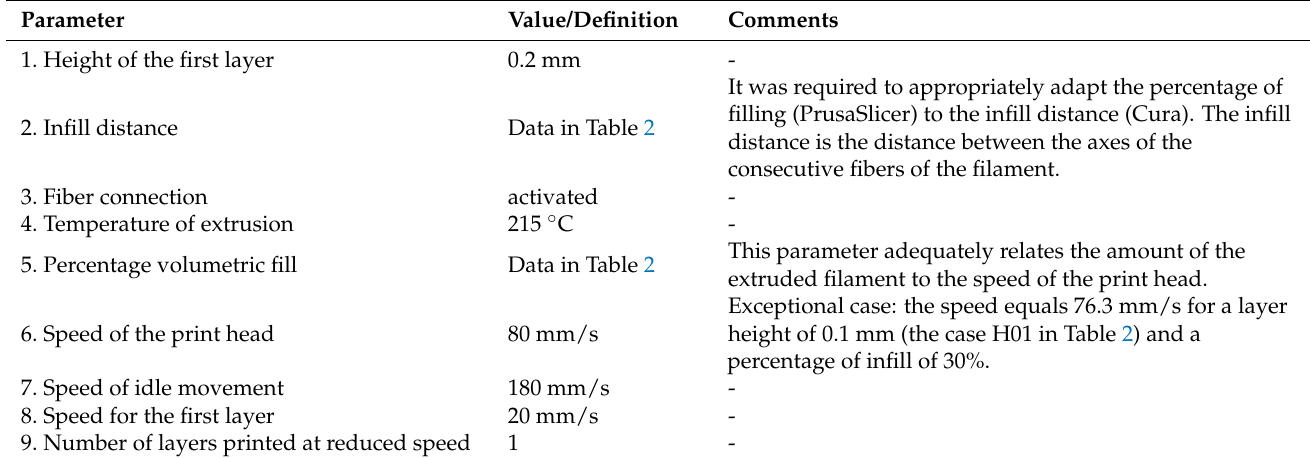
Table 1. Parameters declared for the Cura software—based on the PrusaSlicer settings.